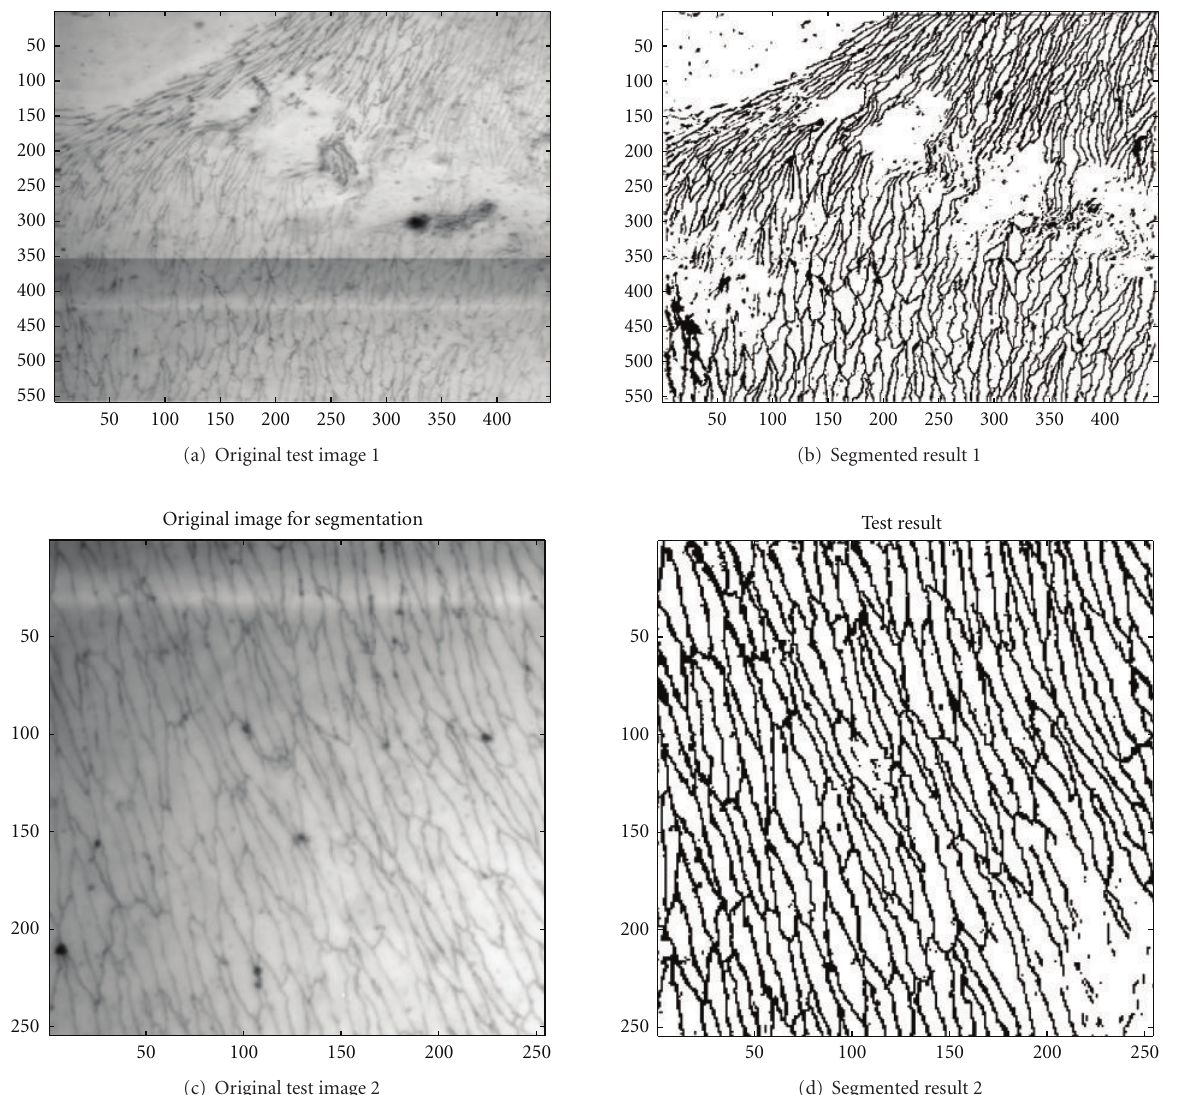
Figure 8: Original image and segmented result using RBF kernel. No other processing has been applied to the SVM output.